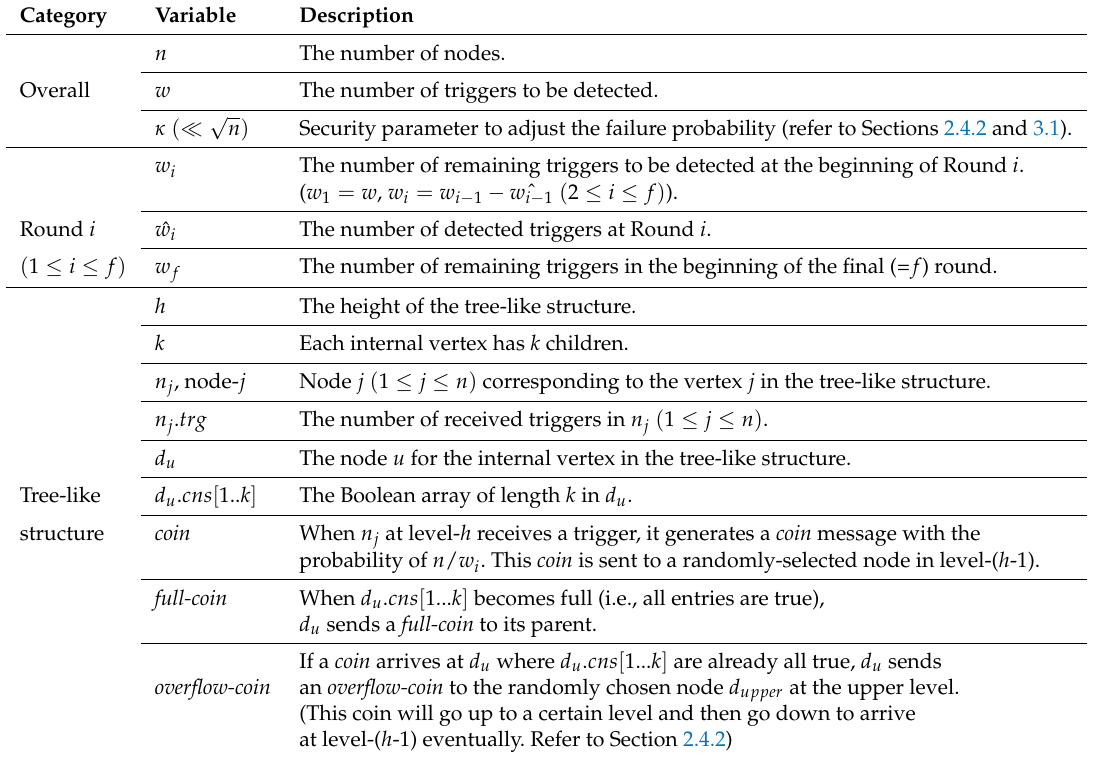
Table 2. Table of